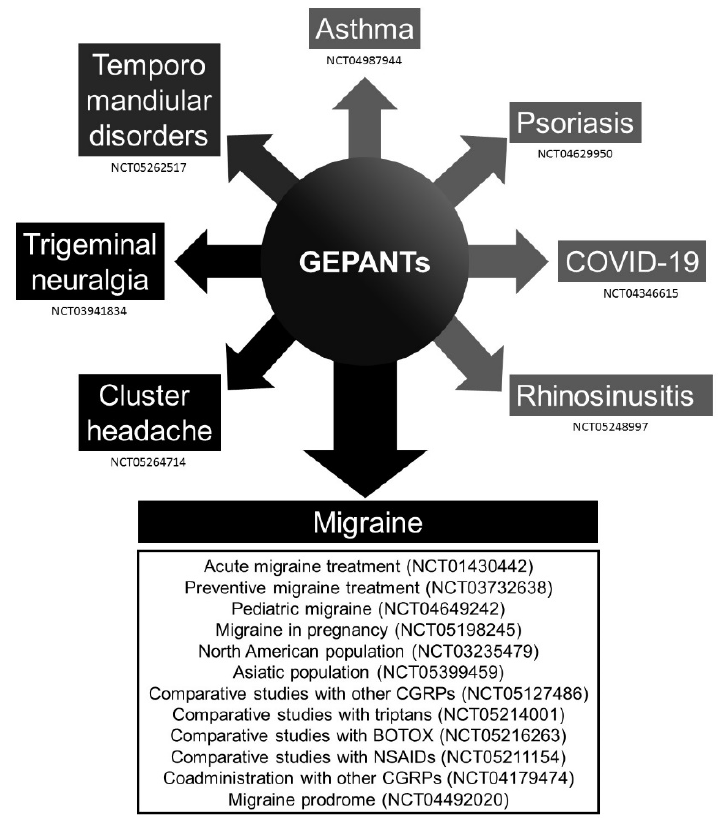
Figure 2. Schematic diagram of the conditions assessed in the clinical trials registered at “ClinicalTrials.gov” with rimegepant, ubrogepant, atogepant, and zavegepant. The colors are graded due to possible different mechanisms related to the calcitonin gene-related peptide (CGRP) pathway.